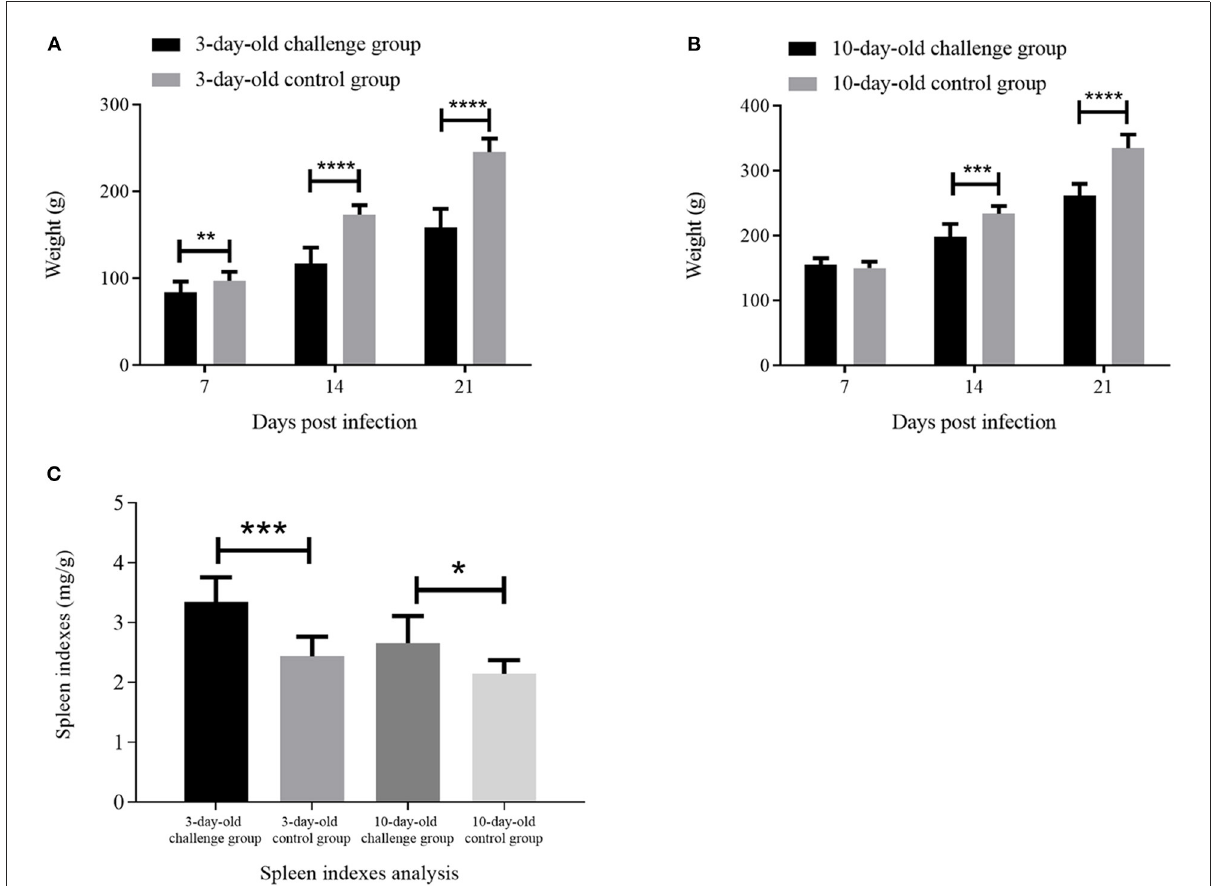
FIGURE5 The weight analysis and spleen indexes analysis. (A) and (B) are the weight analysis of the challenge groups and control groups at 7, 14, and 21 days post infection (dpi); (C) is the spleen indexes analysis of challenge groups and control groups at 21 dpi. * represents p < 0.05; ** represents p < 0.01; *** represents p < 0.001; **** represents p < 0.0001.